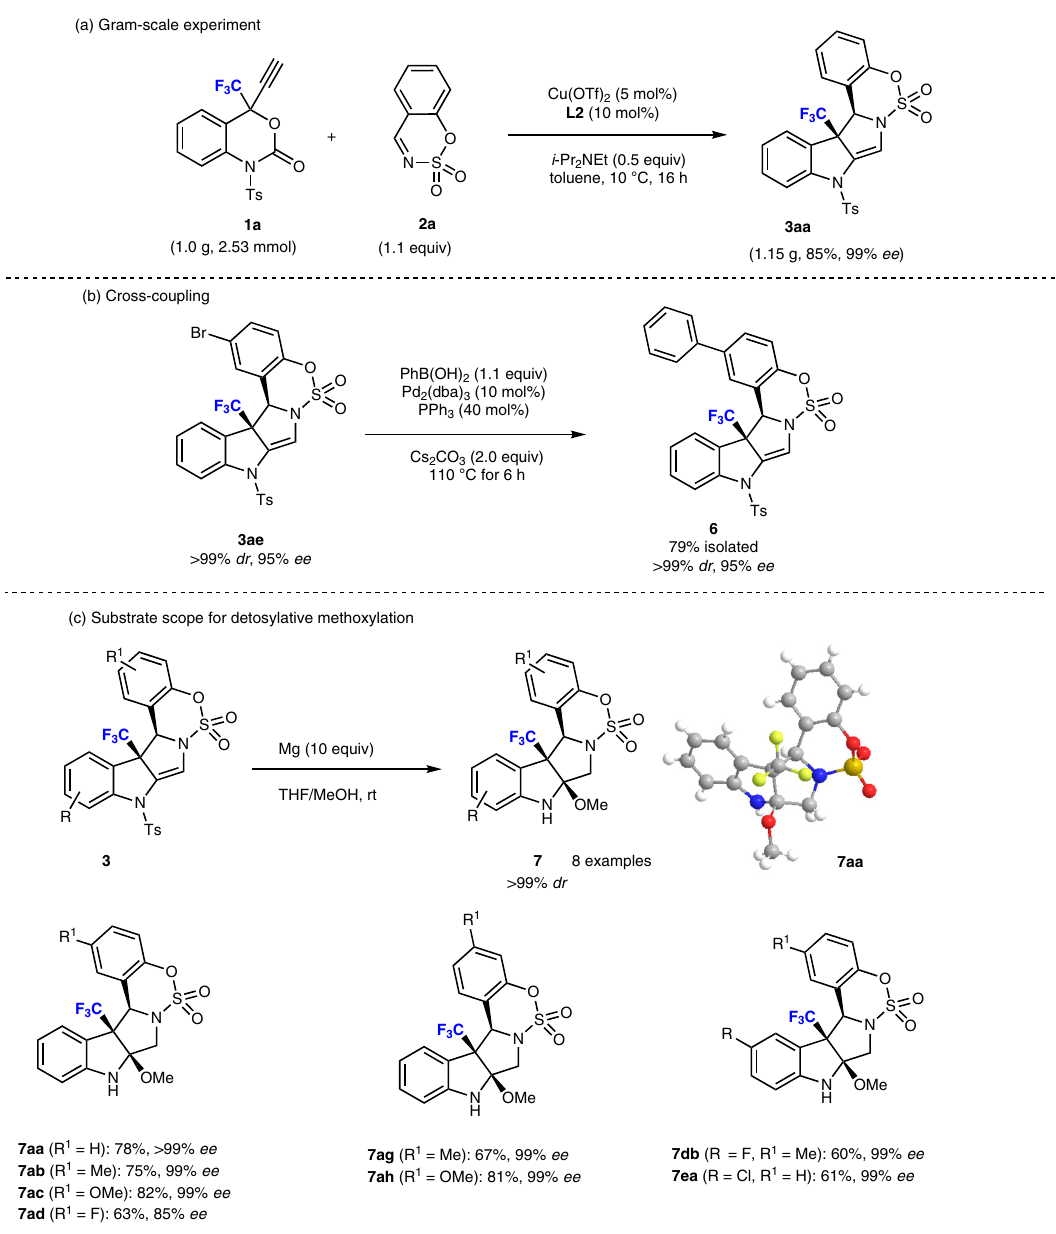
7aa (R 1 = H): 78%, >99% ee 7ab (R 1 = Me): 75%, 99% ee 7ac (R 1 = OMe): 82%, 99% ee 7ad (R 1 = F): 63%, 85% ee Fig. 4 Synthetic utility I. a Gram-scale reaction of 1 with 2 . b Cross-coupling reaction using 3 . c Detosylative methoxylation of 3 to 7